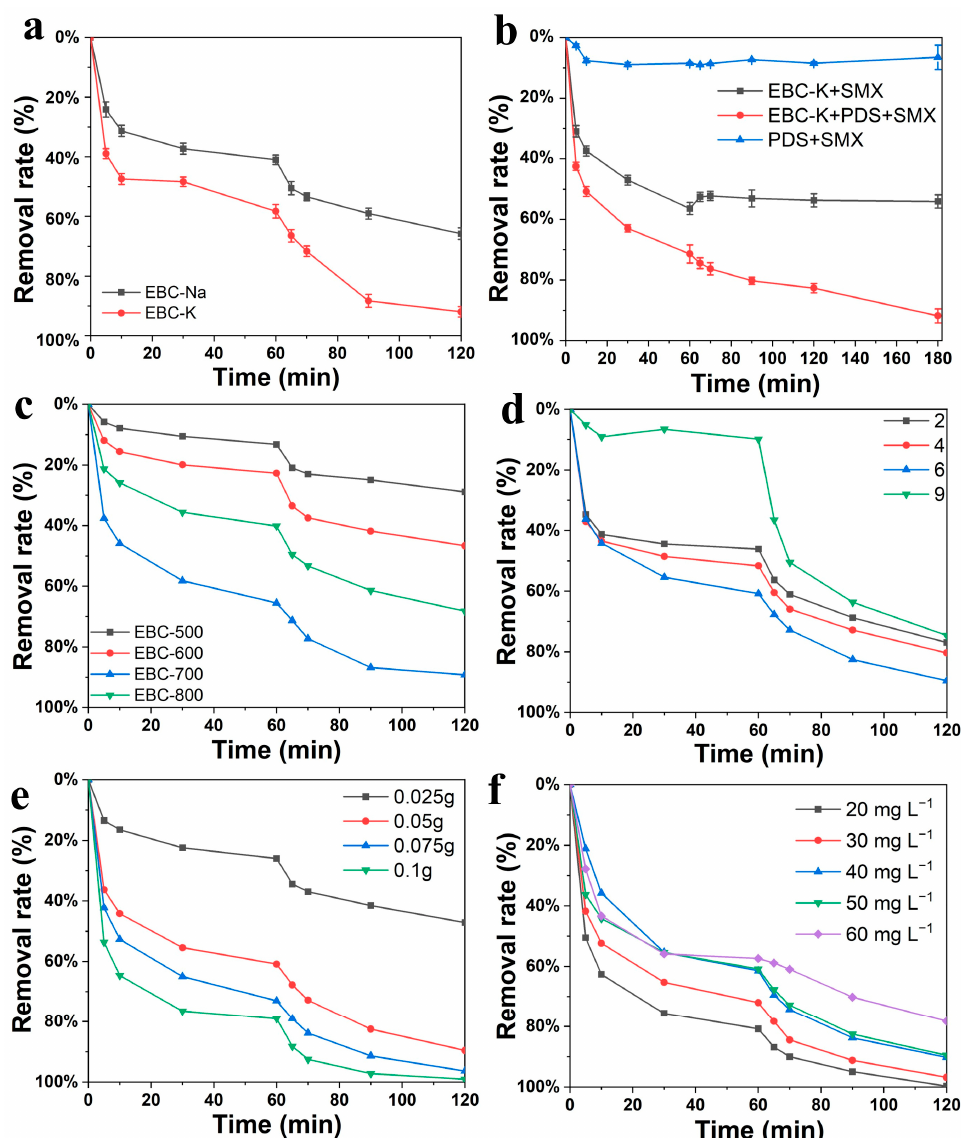
Figure 4. ( a ) The SMX degradation performances of EBC ‐ K and EBC ‐ Na, ( b ) the degradation under different degradation conditions, the detail degradation performances of ( c ) EBC ‐ Ks prepared under varied pyrolysis temperatures, and the optimized EBC ‐ K measured at varied ( d ) initial pH levels, ( e ) bio ‐ carbon dosages, and ( f ) SMX concentrations.